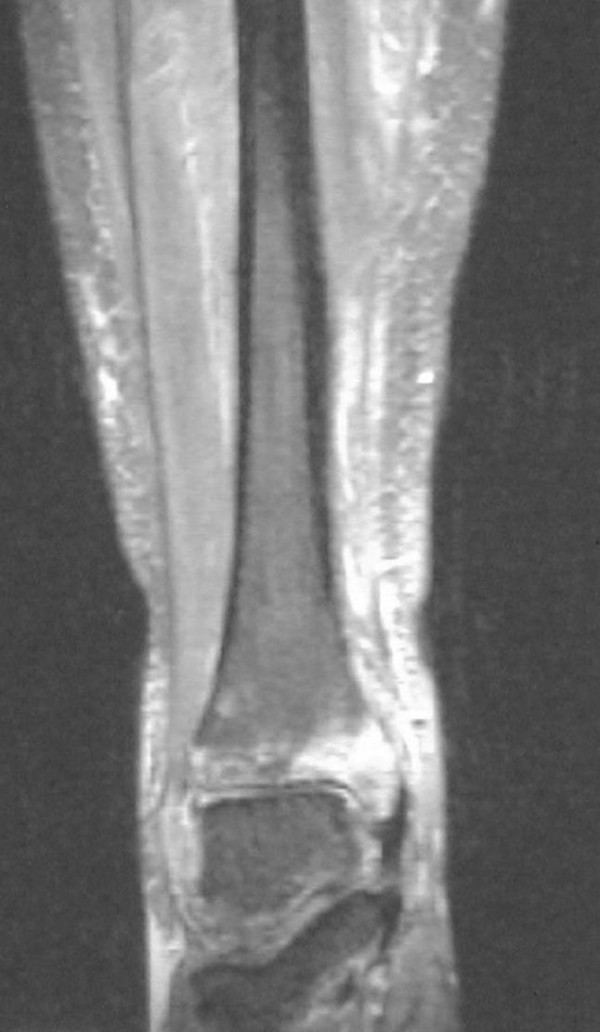
MRI scan one week after open repair of the Achilles tendon. Note the fracture of the medial malleolus